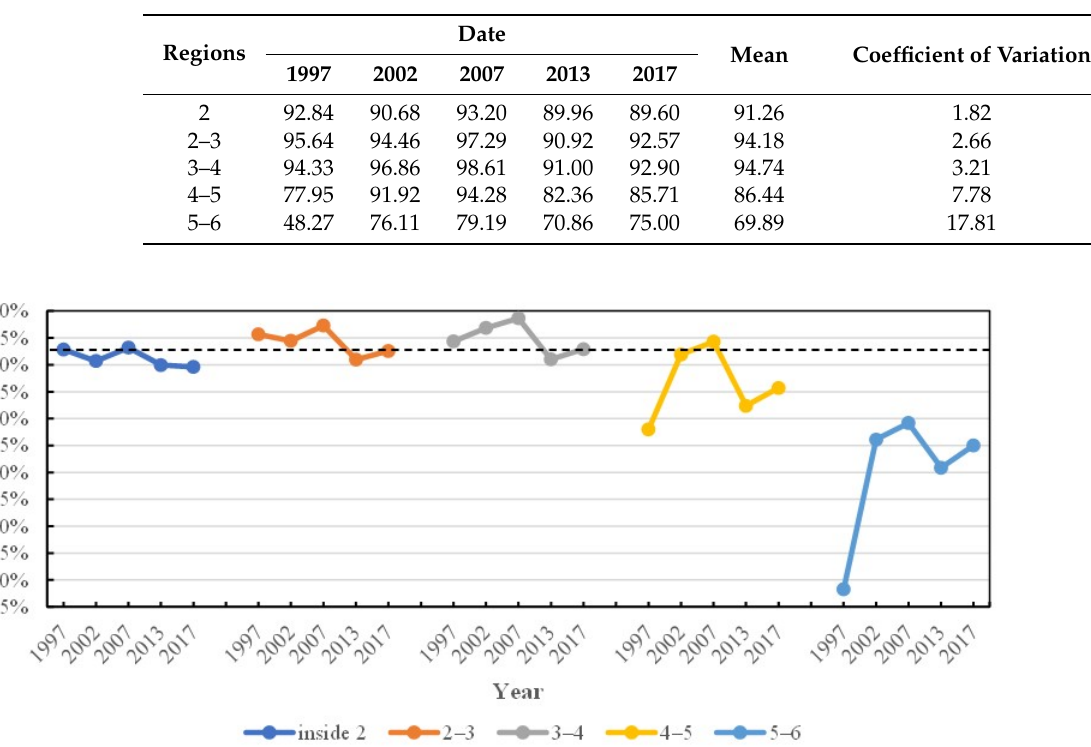
Table 5. Each year’s impervious surface ratio (ISR) in each separated region, and their mean and coefficient of variation (as a percentage).